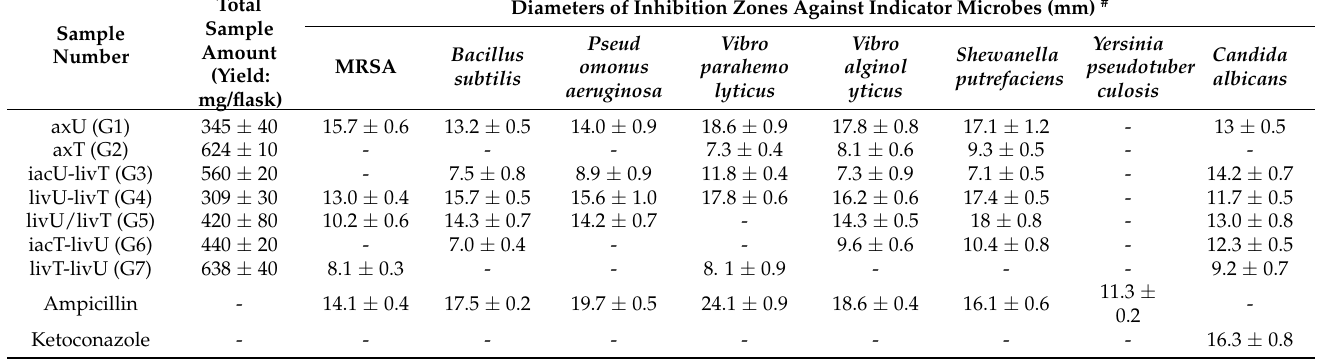
Table 1. The total extract amounts and antimicrobial activities from experiments G1–G7, which were measured using the Oxford Cup method (dosage: 200 mL/well, concentration = 1 mg/mL, concentration for both controls = 0.1 mg/mL, n = 4).